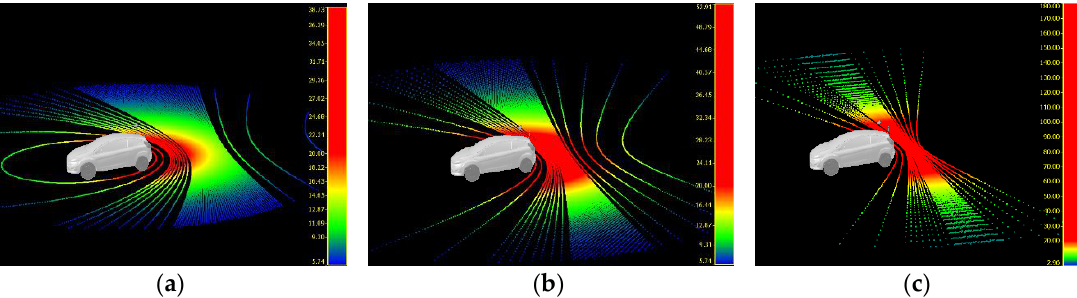
Figure 18. The relation between the Pandar64 Lidar tilt angle and the incidence angle where red points having ≥20° incidence angle on the ground. ( a ) @ 15°tilting angle: the average angle of incidence ≈14°